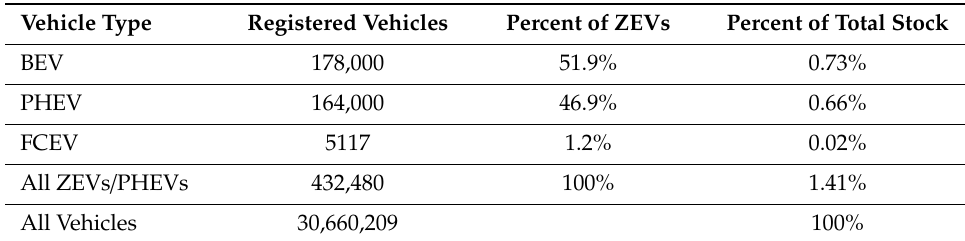
Table 2. Vehicle Stock as of January 2018 from California Department of Motor Vehicles [17].